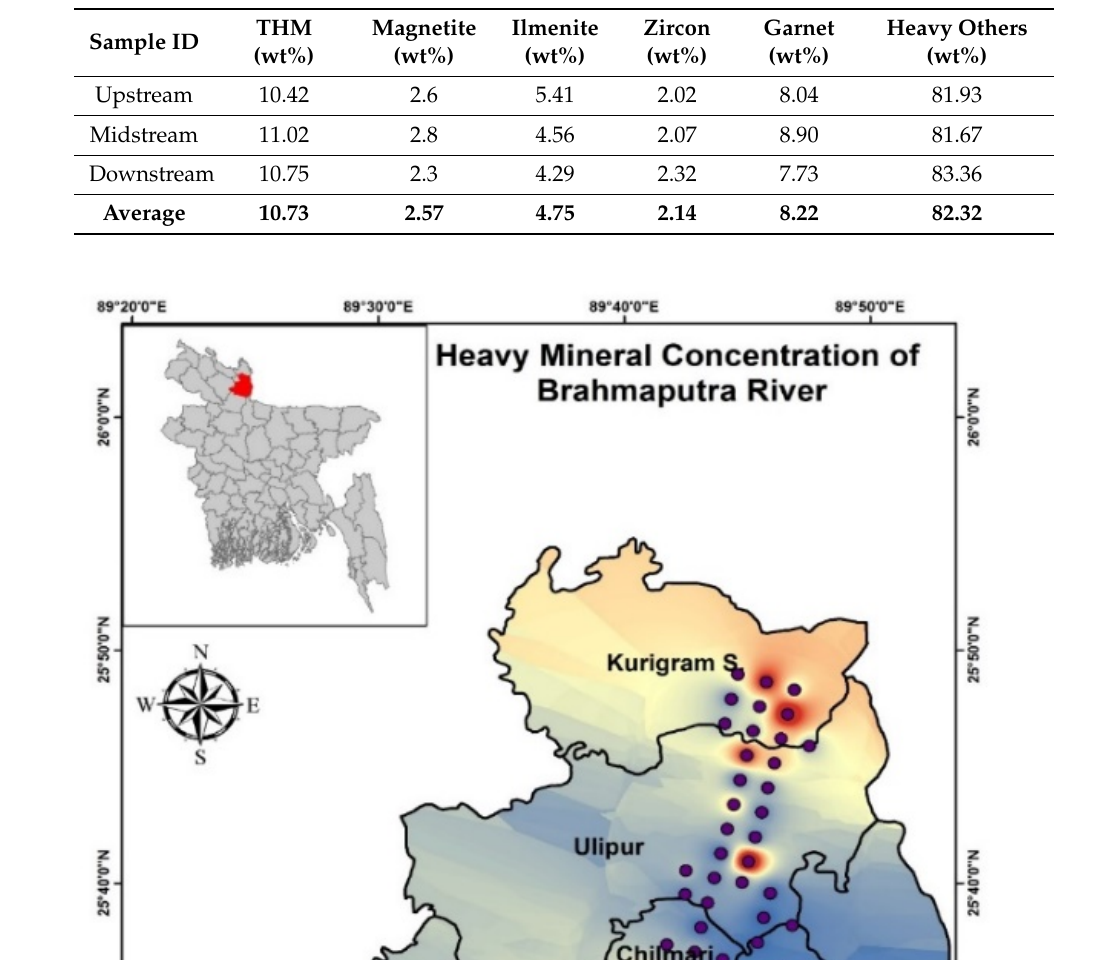
Table 2. The average THM concentration and abundance of VHM within the three stream divisions.